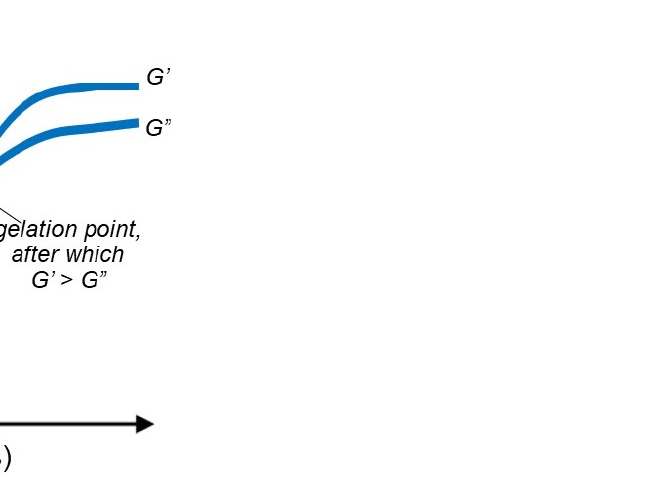
Figure 5. Time sweep experiment shows the formation of the network structure of the hydrogel over time. The crossover point of G’ and G” indicated the gelation point.